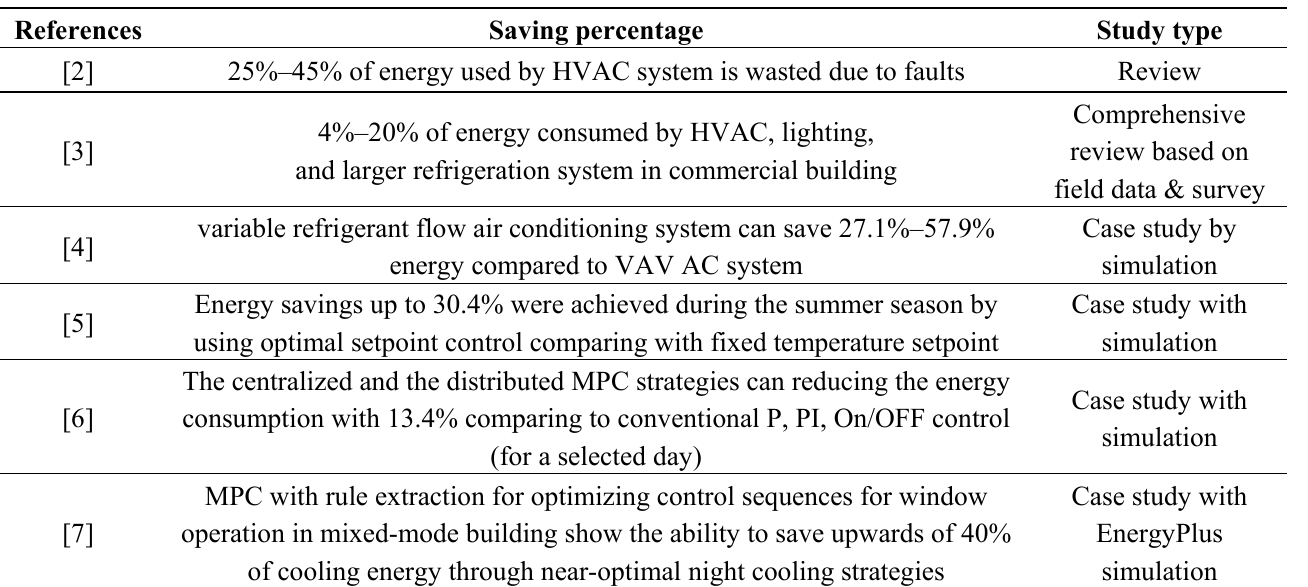
Table 1. Selected references reporting control related energy saving or